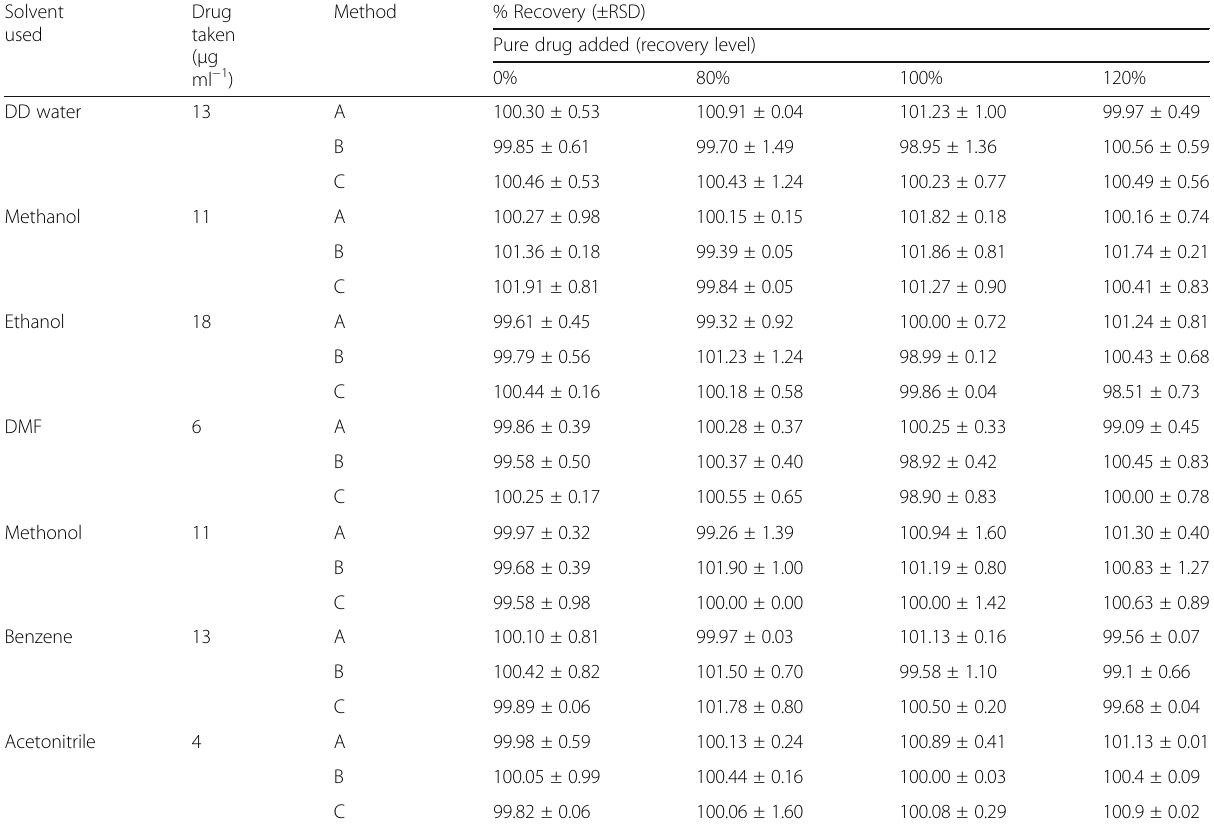
Table 4 Summary of accuracy results by standard addition technique for pharmaceutical product form of satranidazole (STZ )( n = 10) Solvent used